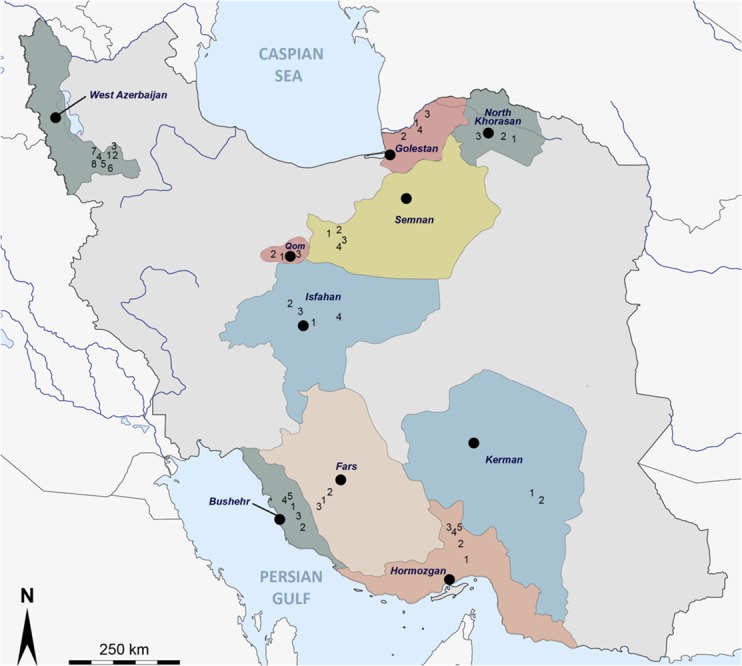
Geographic representation of the sandfly collection regions in Iran.